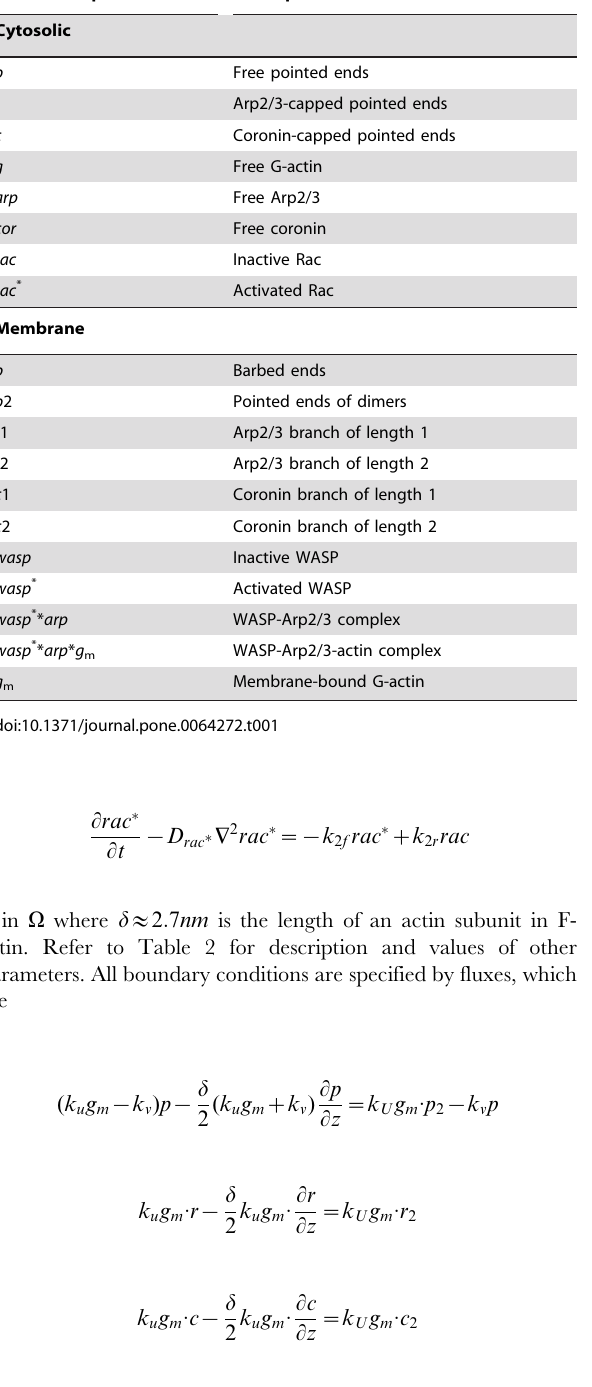
Molecular species